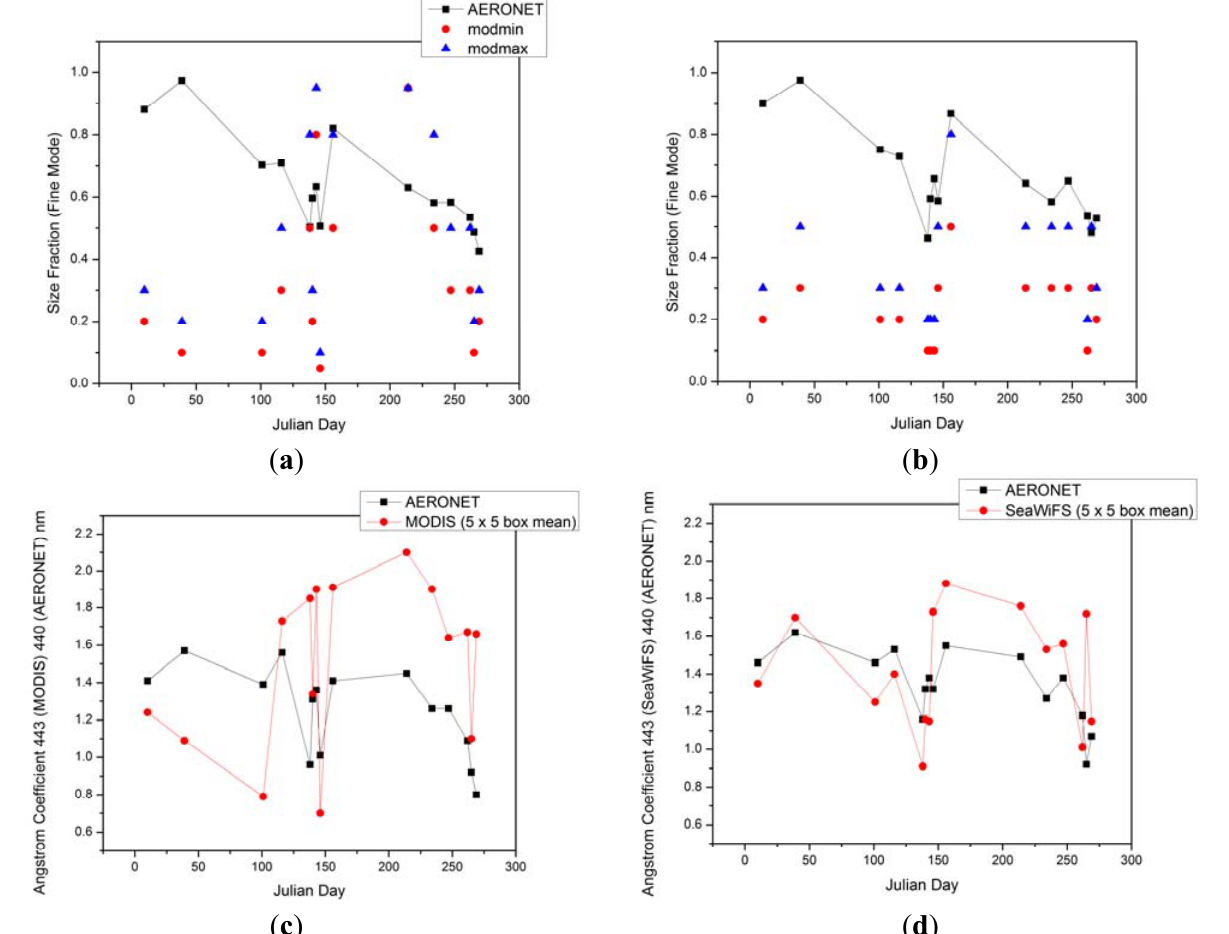
Figure 16. ( a , b ) Satellite-derived size fraction compared to AERONET size fraction and ( c , d ) satellite derived α (443) compared to AERONET α (440) , Venice 2010. (a,c) MODIS. (b,d) SeaWiFS. The AERONET data were selected closest in time to the satellite